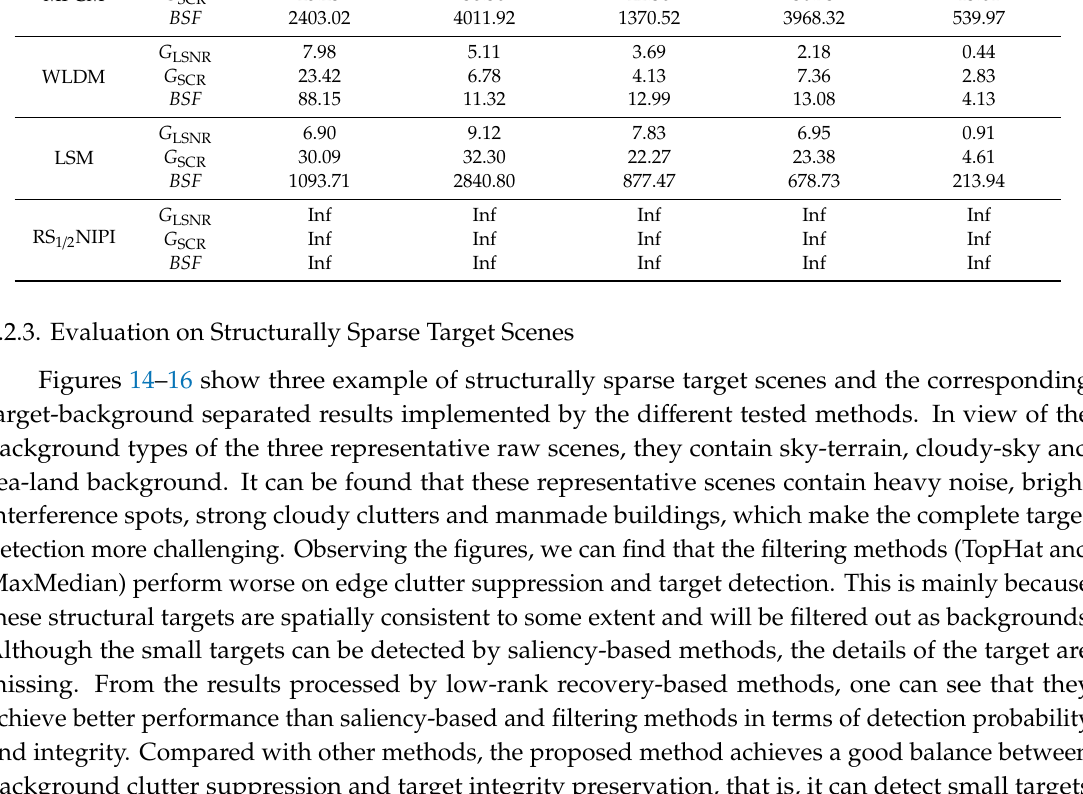
Figure 15. An example of structurally sparse target scenes and the corresponding detection results obtained by the proposed method compared with ten competitive methods.